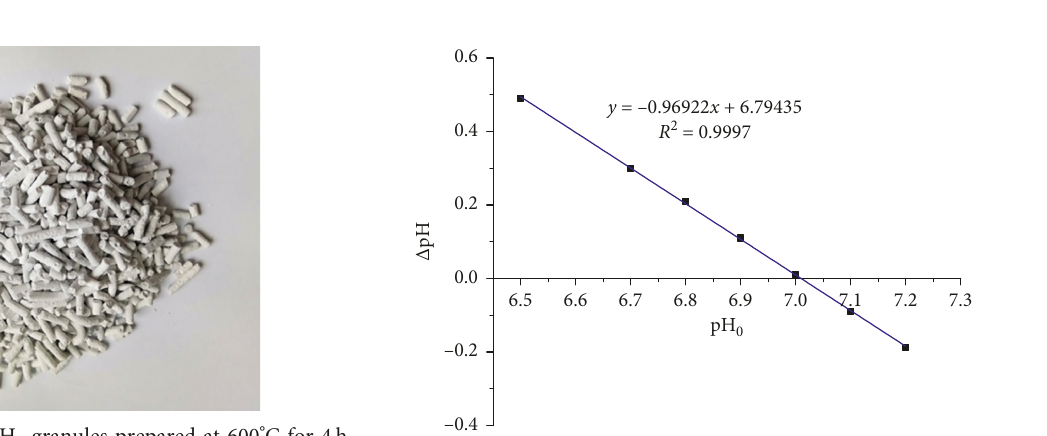
Figure 7: Digital photo of H 3 granules prepared at 600 (PVA/HAp 3/20). Figure 8: The variation of (cid:31)